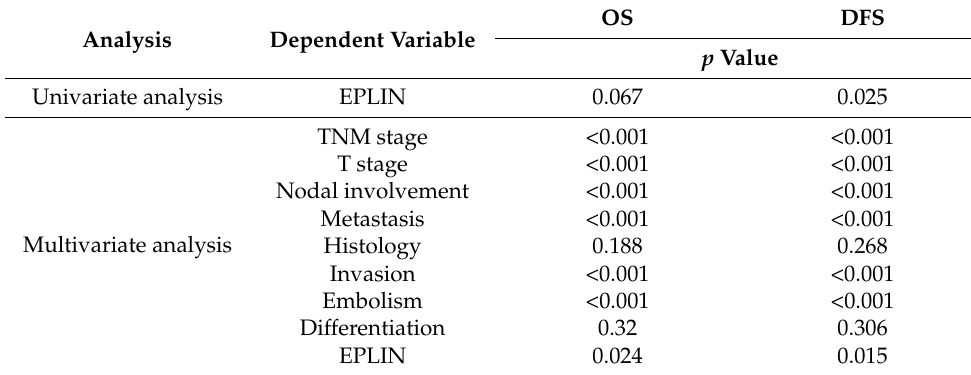
Figure 2. Relationship between EPLIN expression and clinical survival outcomes in gastric cancer cohort. ( A ): Longer overall survival was seen in patients with higher EPLIN expression compared to those with relatively lower EPLIN expression. ( B ): Patients with higher levels of EPLIN transcript had a significantly longer disease-free survival than those with lower levels of EPLIN transcript. Table 3. The implication of EPLIN transcript expression in clinical outcomes in patients with gastric can-